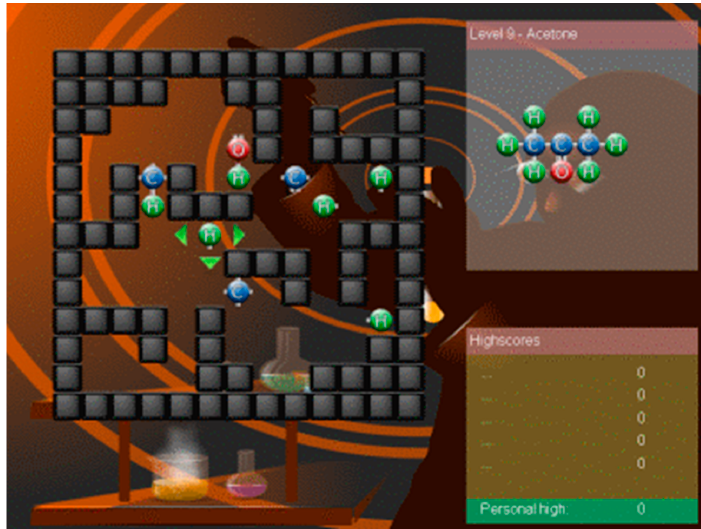
Figure 1. A screenshot of the game KAtomic , used to demonstrate how the entire interface of a game consists of representations of underlying content. KAtomic is copyright 1998–2012 KAtomic Team, released under the GNU General Public License (GPL) version 2.